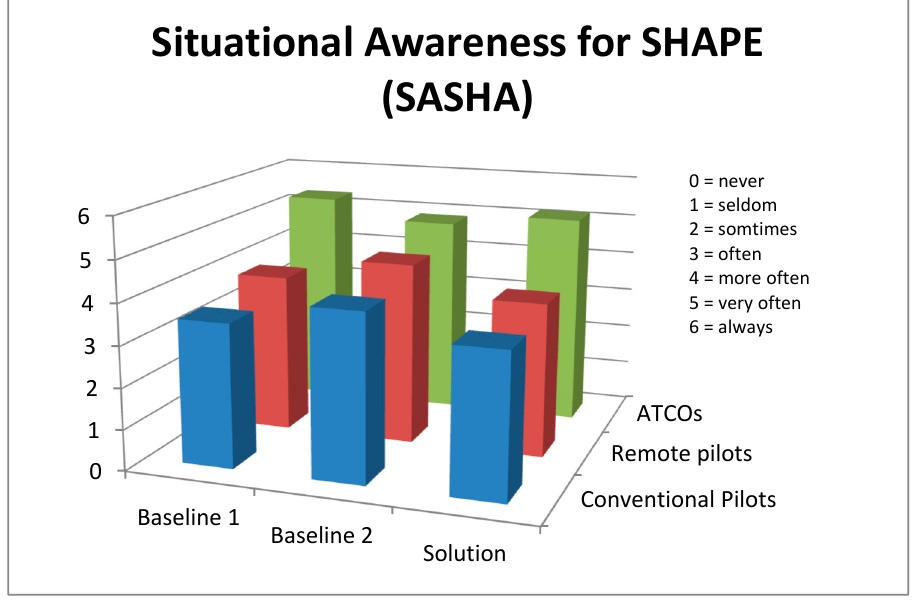
Figure 4. Results of SASHA questionnaire, per scenario, per expert group.